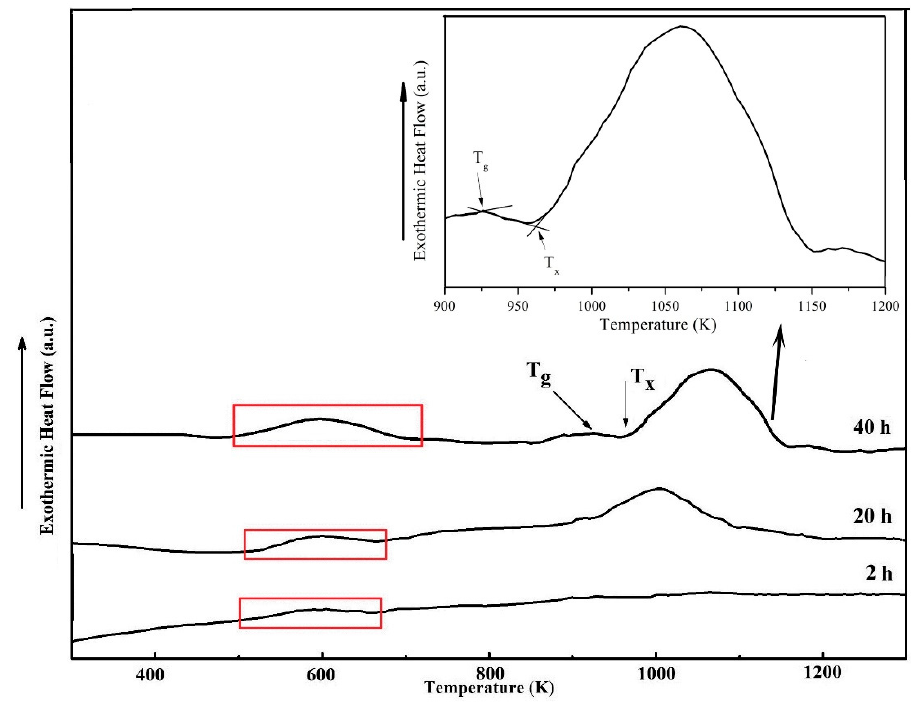
Figure 8. DSC curves of the powder particles after ball milling for different times at 500 rpm; the enlarged view of local area of the DSC curve for the sample after 40 h of ball milling clearly shows the determination of T g (glass transition temperature) and T x (amorphous-crystallization initial temperature) by the tangent method.